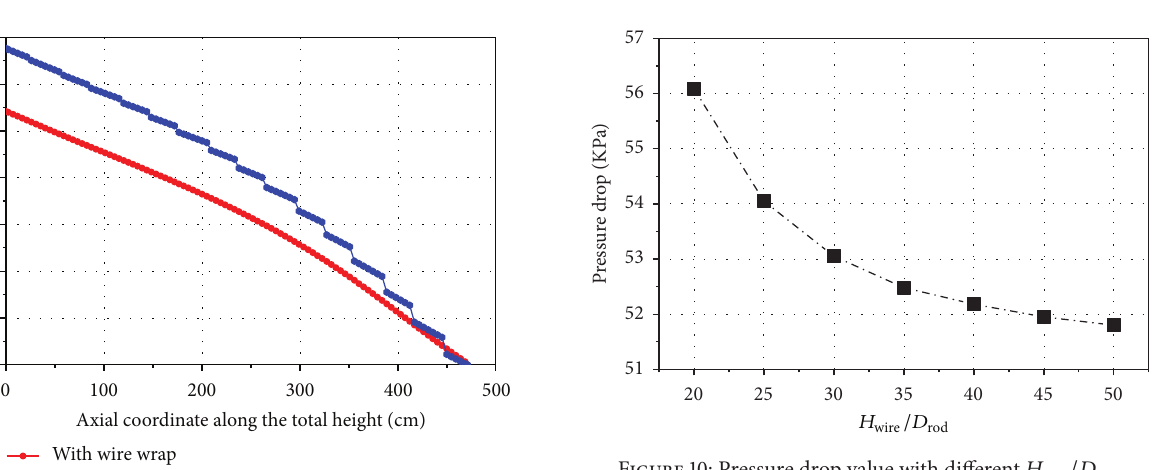
Figure 10: Pressure drop value with different 𝐻